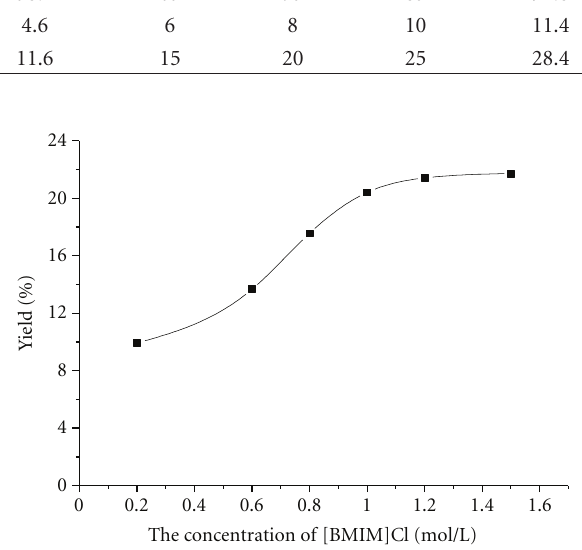
Figure 2: E ff ects of [Bmim] Cl concentration on the yield of pectin.